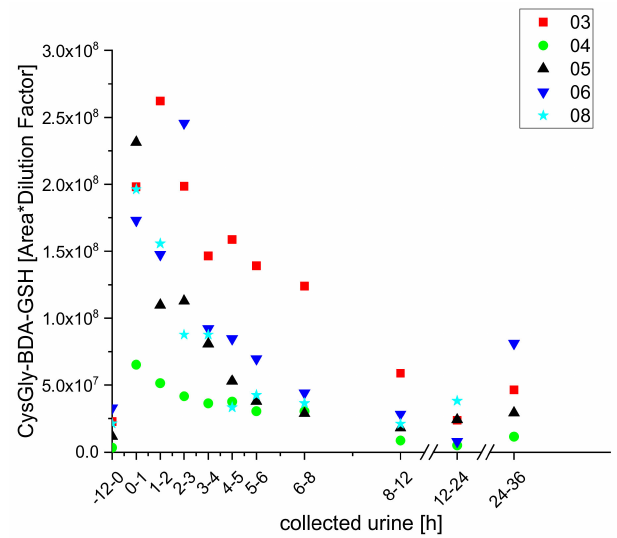
Figure 8. Excretion kinetics of CysGly-BDA-GSH: UPLC-qToF-MS / MS measurements of contents in samples of urine from participants three, four, five, six, and eight at indicated times after co ff ee consumption (h).